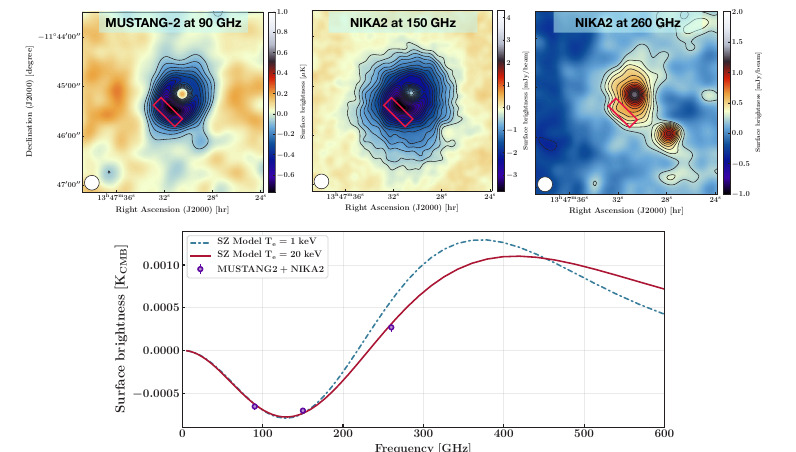
Figure 2. Preliminary SZ (top) and X-ray (bottom) maps obtained with the MUSTANG-2 (far left) and NIKA2 camera at 90 GHz and 150 GHz and the ACIS-I instrument on-board Chandra for four clusters in the MOO-X / SZ sample. Contours in the MUSTANG-2 and NIKA2 maps start at 3 σ with 1 σ steps. Photon count iso-contours are shown in the X-ray maps for visual purposes. We indicate the name and redshift of each cluster in the upper and Figure 3. Top: Preliminary SZ maps obtained with MUSTANG-2 and NIKA2 at 90, 150, and 260 GHz, respec- lower panels, respectively. All maps have a side length of about 4 arcmin. ⇠ tively. Signal-to-noise contours start at 3 σ with 1 σ increments. We highlight the region considered for the SZ surface brightness measurements shown in the bottom panel with red rectangles. Bottom: Preliminary measure- ments of the SZ surface brightness in the shock region of the cluster at the three frequencies available with NIKA2 and MUSTANG-2 (purple points) along with the expected tSZ spectra for ICM temperatures of 1 and 20